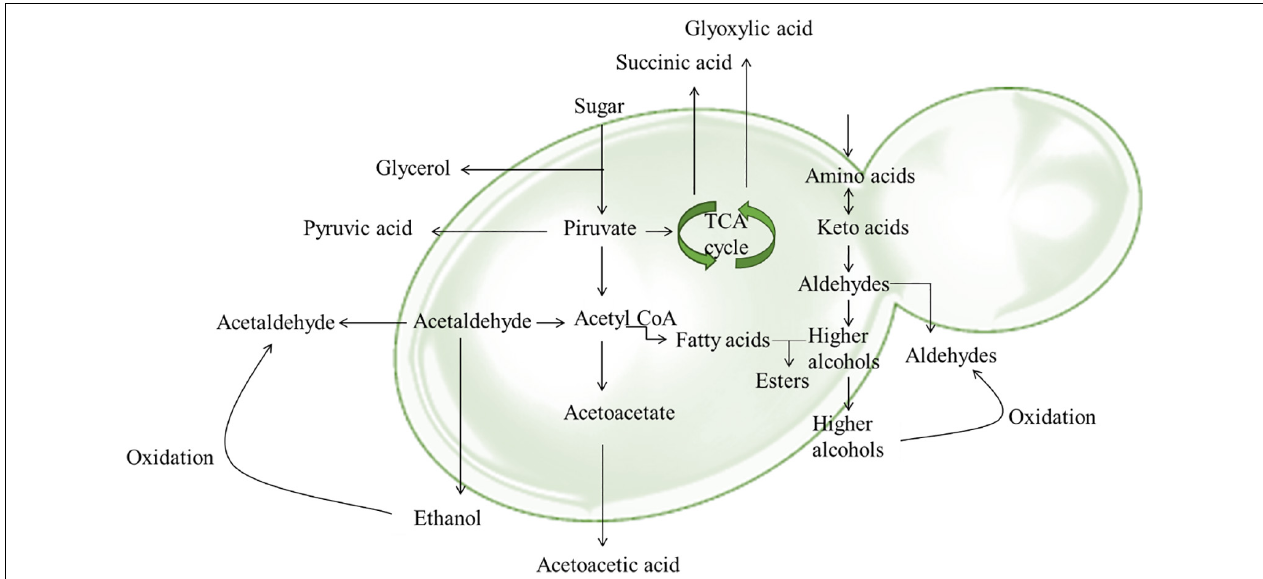
FIGURE 3 | Main pathways involved in the formation of anthocyanin derivatives and polymeric